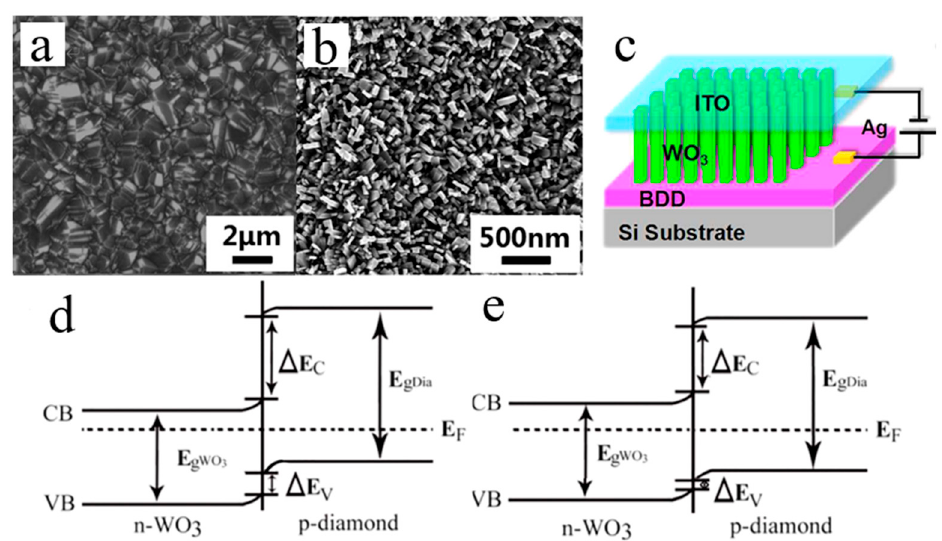
Figure 21. ( a ) SEM morphology of the BDD substrate and ( b ) WO 3 NRs on the BDD substrate. ( c ) Schematic diagram of the n-WO 3 NRs/p-BDD heterojunction. ( d ) Room temperature and ( e ) higher-temperature energy band diagrams of the n-WO 3 NRs/p-BDD heterojunction [34].